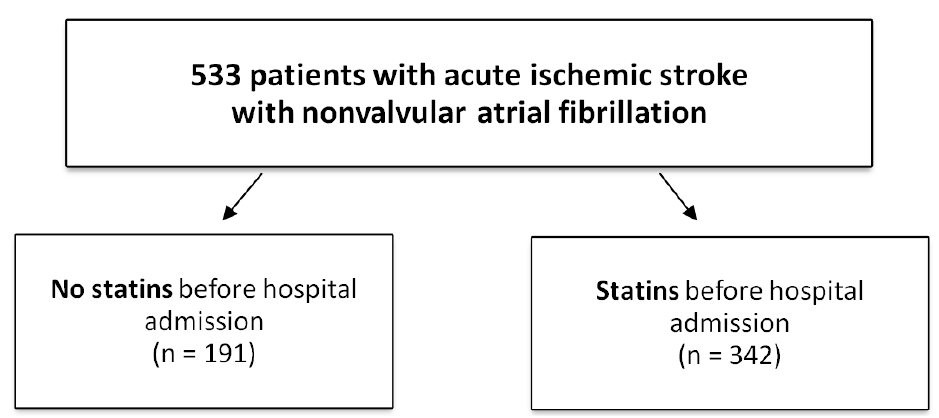
Figure 1. Study flowchart.